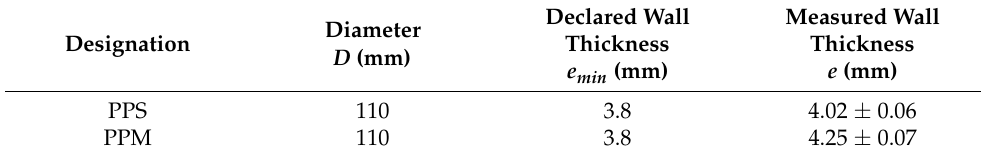
Table 1. Types of tested pipes.